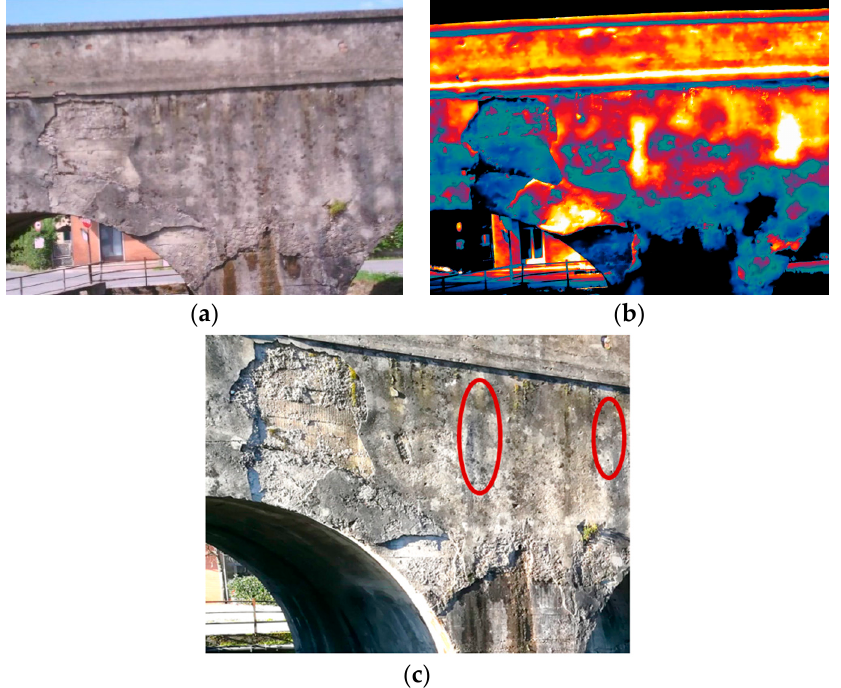
Figure 1. Thermographic acquisitions on a railway masonry bridge at Debbia (Massa, Italy): ( a ) Co- registered image in the visible; ( b ) False-color coded thermographic image; ( c ) Photo of the examined surface hit by grazing